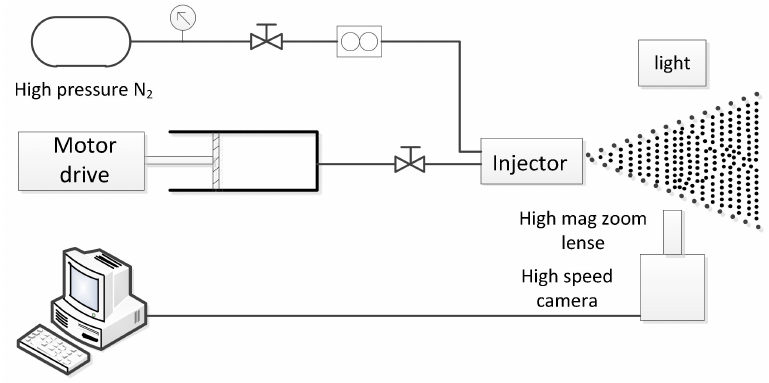
Figure 2. Schematic of experimental facility.